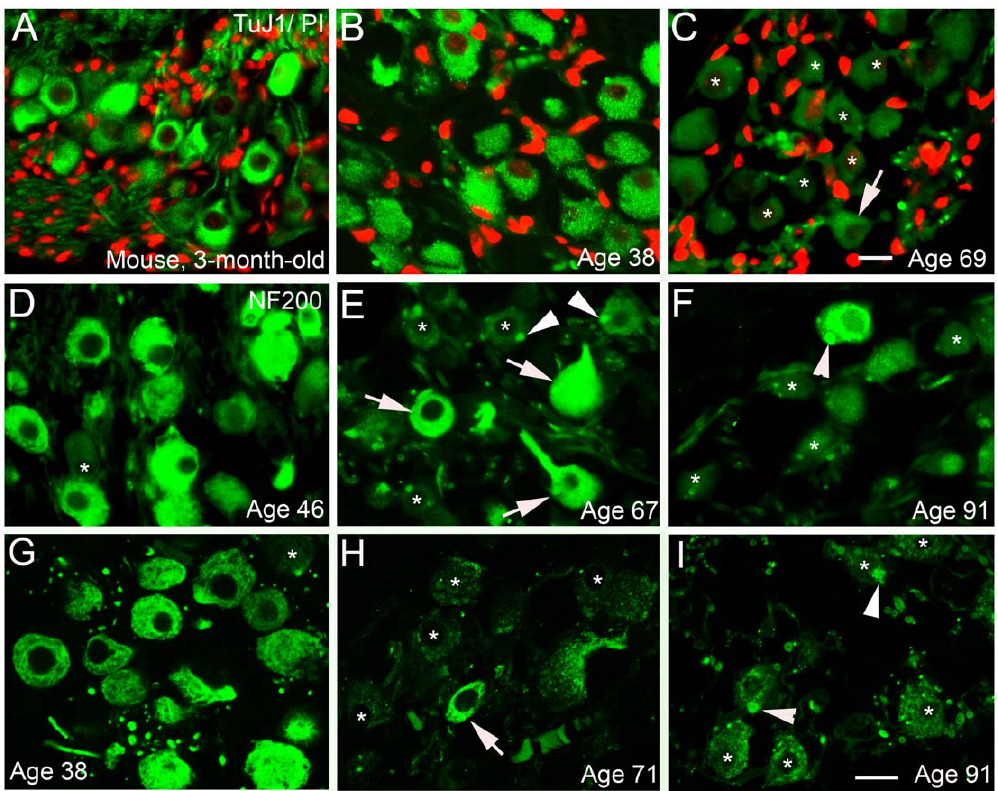
Figure 8. Age-related changes in TuJ1 and NF 200 expression in human ears. A: TuJ1 + neurons in a paraffin section from the middle turn of a young adult mouse. B–C: TuJ1 + neurons in the middle turns from ( B ) a 38-year-old donor (H18) and ( C ) a 69-year-old donor (H4). A marked decrease in TuJ1 immunostaining (asterisks) was seen in SGNs of the older ear. The white arrow indicates a neuron with a relatively normal level of TuJ1 immunoreactivity. Nuclei were counterstained with PI (red). D, E, F: A marked decrease of NF200 immunoreactivity was seen in many SGNs of older donors. NF200 + neurons (green) from the middle turns of ( D ) a 46-year-old (H26), ( E ) a 67-year-old (H19), and ( F ) a 91-year-old donor (H3). Asterisks indicate SGNs with a lower level of NF200 immunoreactivity. White arrows indicate SGNs with a level of NF200 immunoreactivity more similar to that of SGNs from the 46-year-old donor shown in D . Note the punctuate inclusions (white arrowheads) in the cytoplasm of some NF200 + SGNs indicating that neurofilament aggregation occurs in older ears. G, H, I: Confocal images showing a reduction in both the number of NF200 + neurons and decreased immunostaining intensity for NF200 in most surviving SGNs in older donors. Asterisks indicate SGNs with a lower level of NF200 immunoreactivity. A white arrow points to an SGN with a normal level of NF200 immunoreactivity. Punctuate inclusions (white arrowheads) were seen in the cytoplasm of many NF200 + SGNs in the 91-year-old donor. Scale bars, 8 m m in C (applies to A–C ); 7 m m in I (applies to D–I ).